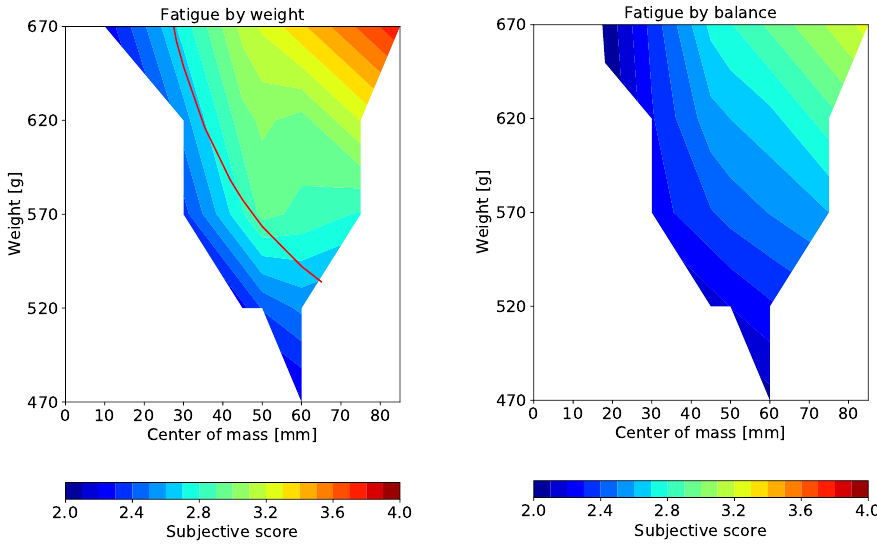
Figure 12. Variation in fatigue due to weight and